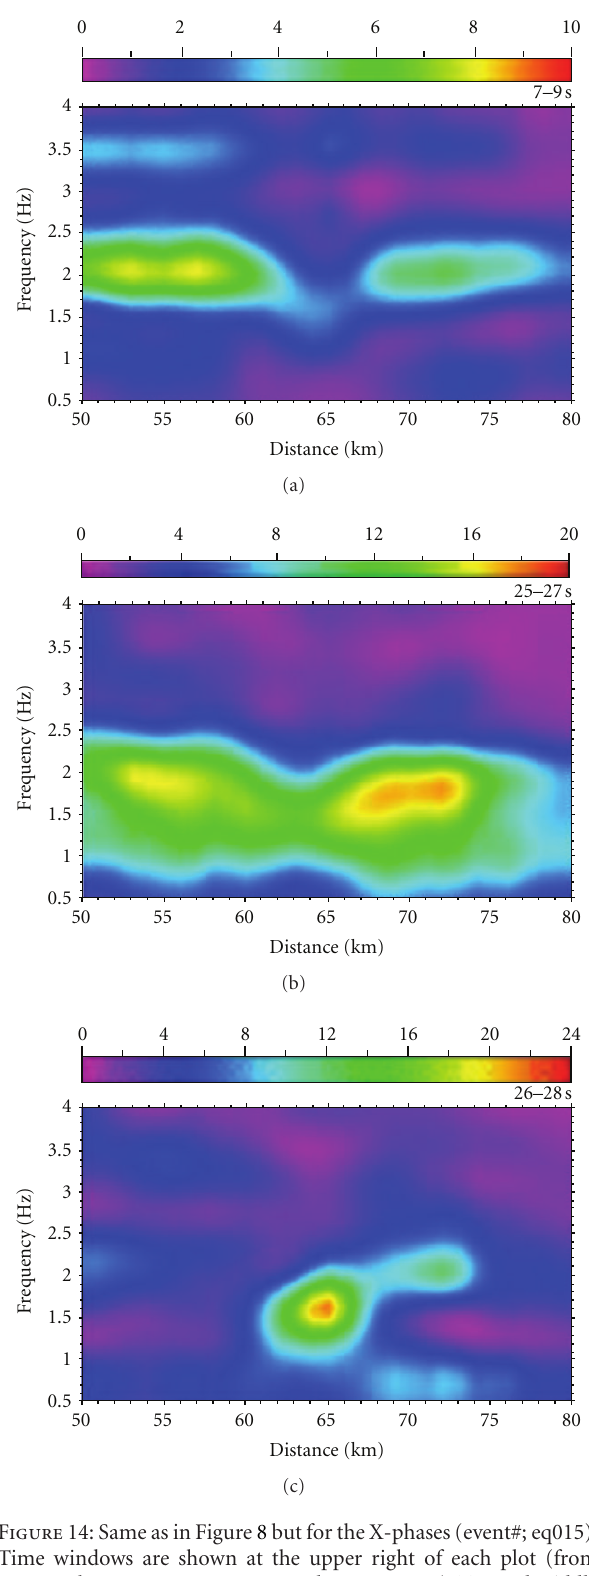
Figure 14: Same as in Figure 8 but for the X-phases (event#; eq015). Time windows are shown at the upper right of each plot (from upper to lower; 24–26 s, 25–27 s, and 26-28 s, resp.). Top and middle show the gap of high energy of 2.0 Hz at around 65 km, and the bottom shows the peak of 1.5Hz just a second late after the time window showing the gap in the